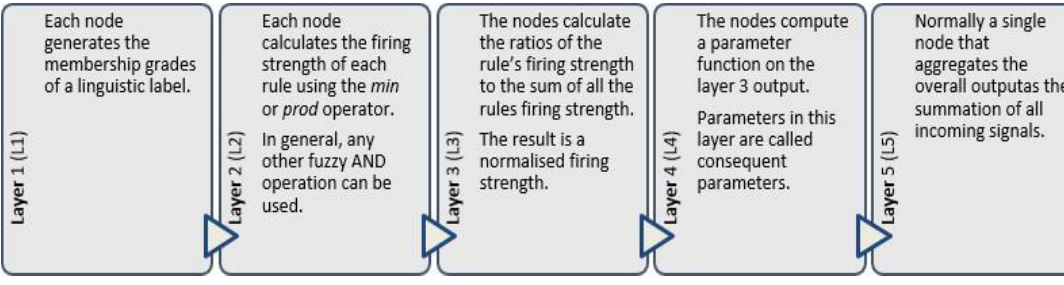
Figure 4. ANFIS with 5 layers of neurons.